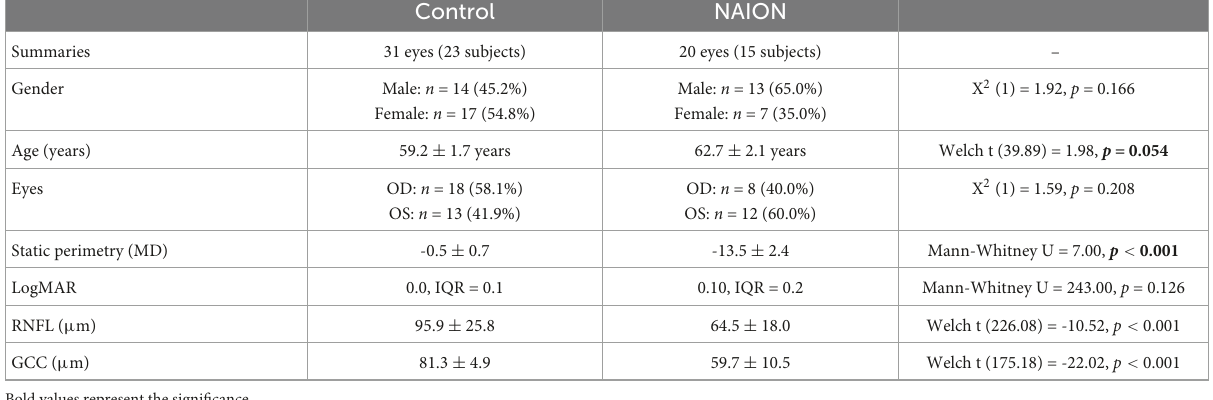
TABLE 1 Study population demographics of control and patient (eyes) with chronic non-arteritic anterior ischemic optic neuropathy (NAION). Control